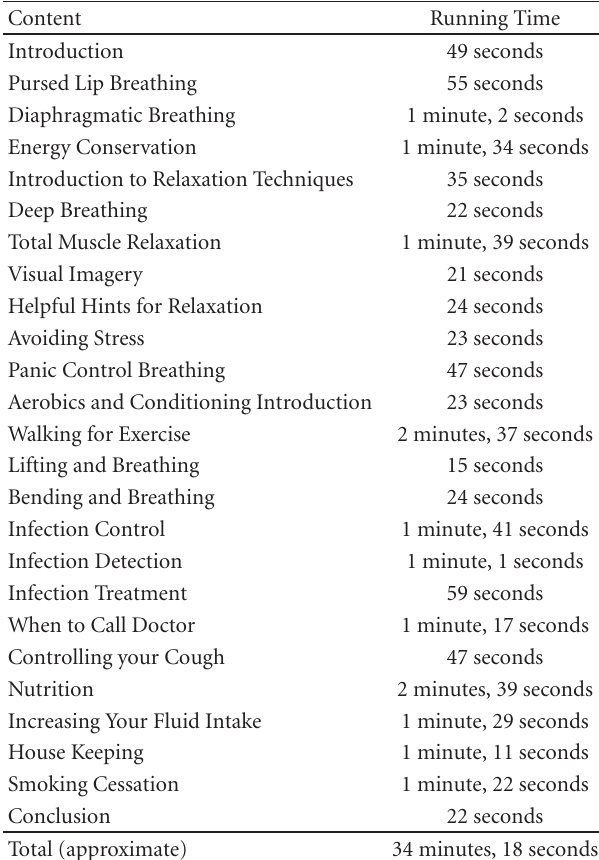
Table 4: Final segments included on DVD